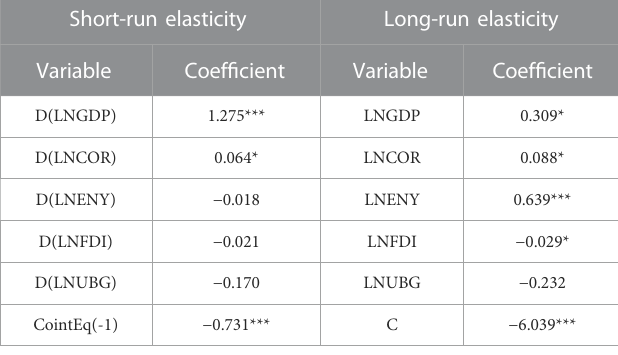
TABLE 6 Short-run and long-run elasticities. Short-run